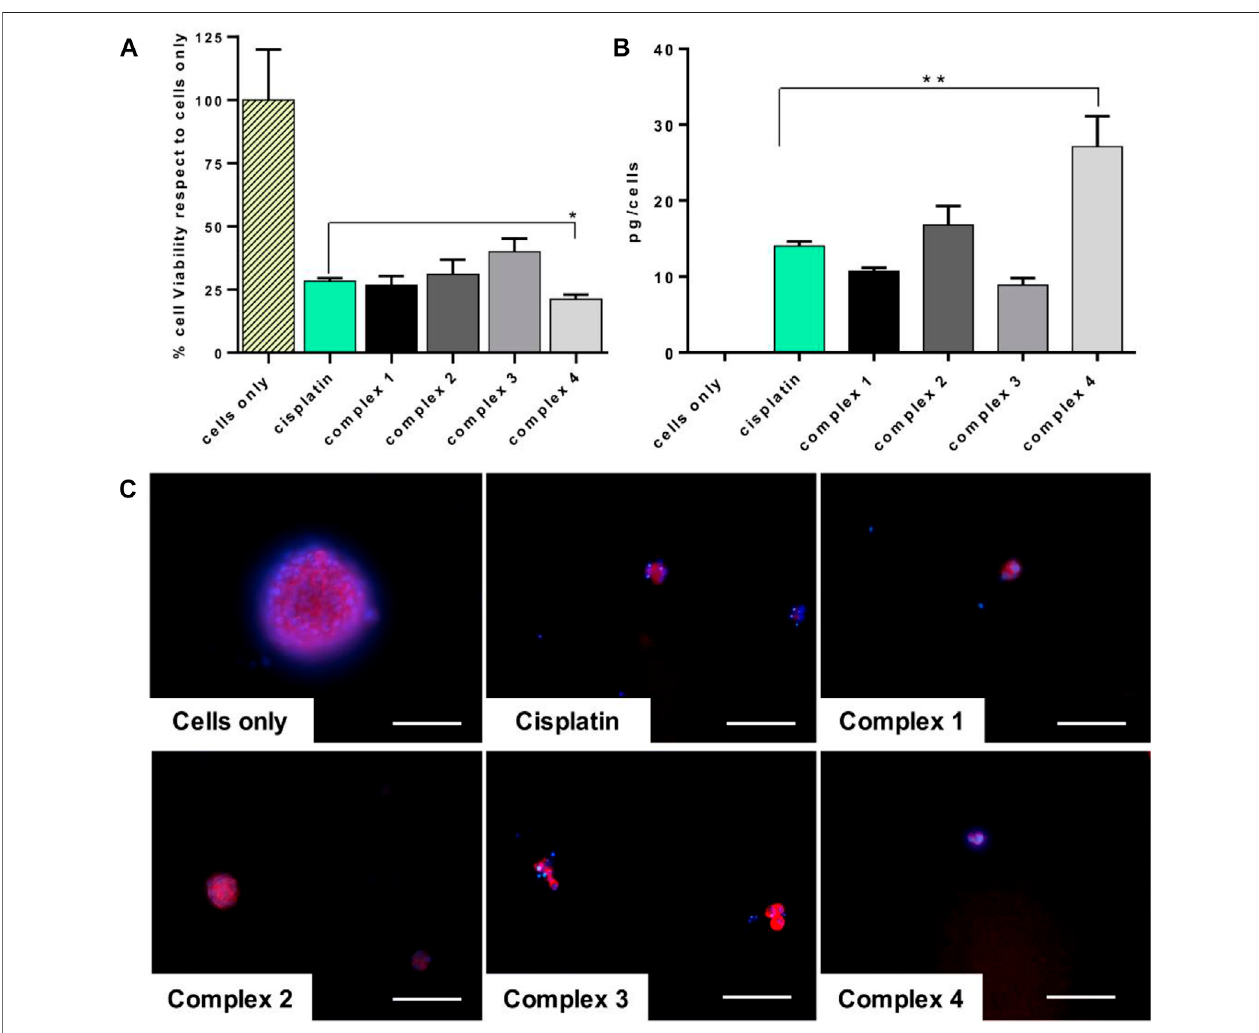
FIGURE5| Cisplatinandcomplexes 1 – 4 effectonCSCs.CSCstreatedfor72 hwith30 µMofdrugs. (A) MTTassay.Mean ± SEMofthepercentageofcellviability respect to cells only (* p value ≤ 0.05). (B) ICP-OES analysis. Cellular uptake of picograms of platinum ions (mean ± SEM) per cell are expressed in the graph (** p value ≤ 0.01). (C) Actin and DAPI staining of CSCs. F-actin fi laments in red; cell nuclei in blue. Scale bars 100 µm.